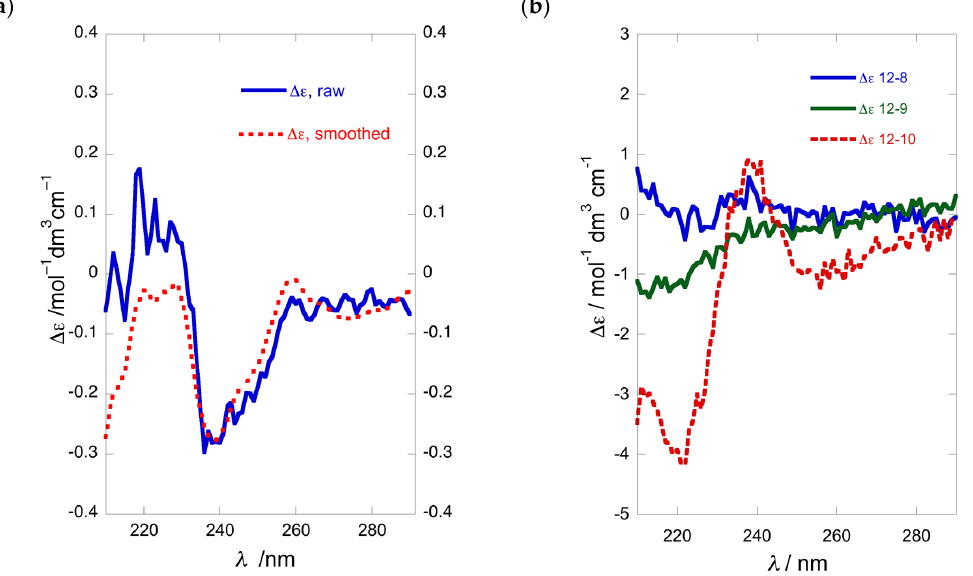
Figure 4. ECD of 1b (MeOH, 23 °C ): ( a ) ‘near racemic’ ( R )- 1b (blue) and fitted curve (red); ( b ) overlay of three samples of 1b prepared from 1a collected at different locations (Table 1).